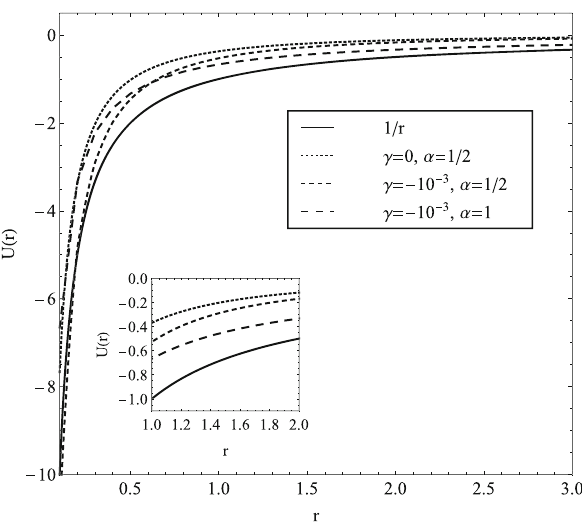
Fig. 3 The effective potential for 4 D linearized softly massive quadratic gravity